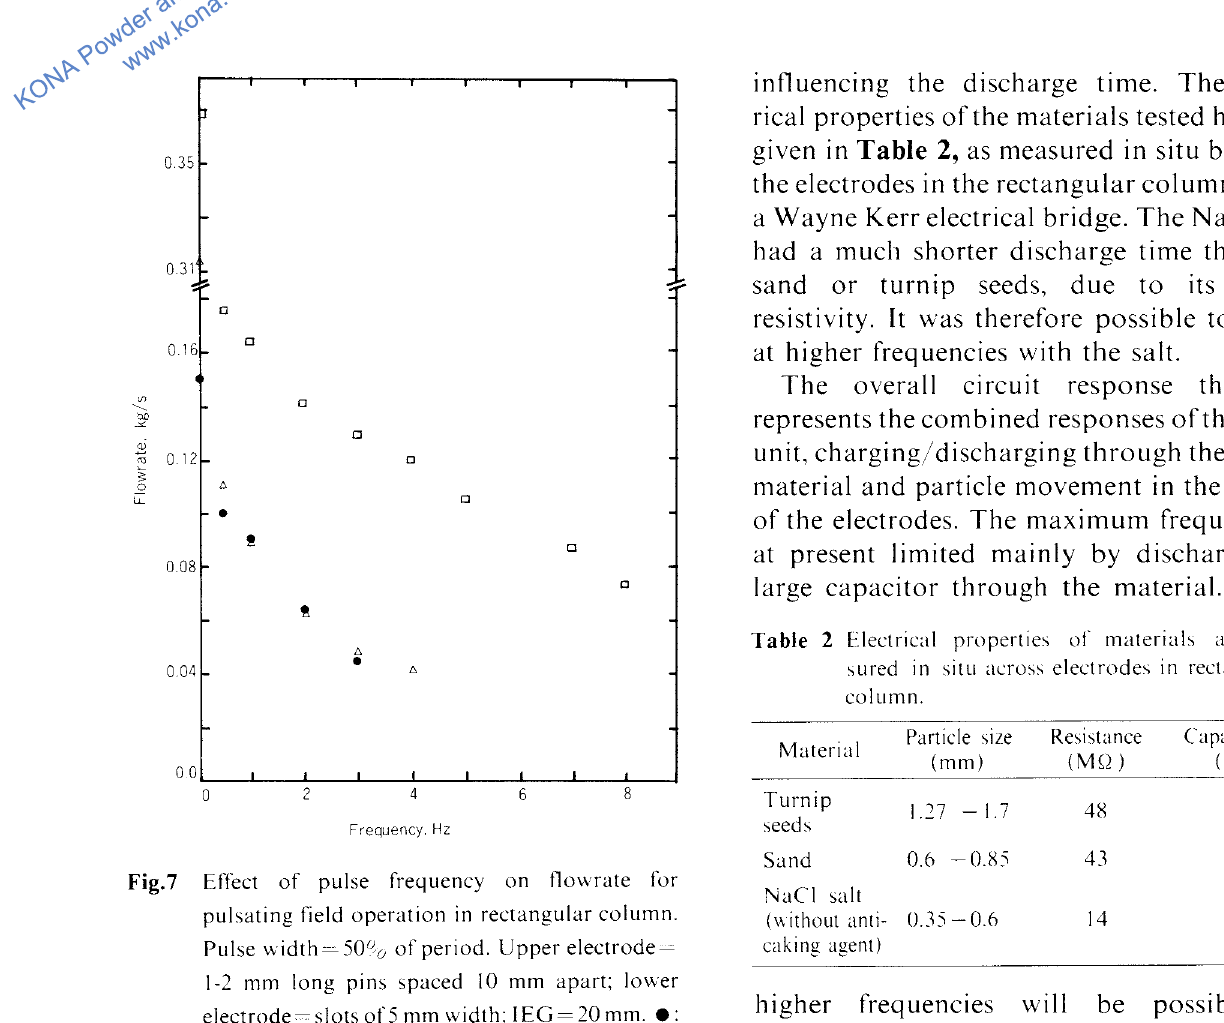
Table 2 Electrical properties of materials as mea sured in situ across electrodes in rectangular